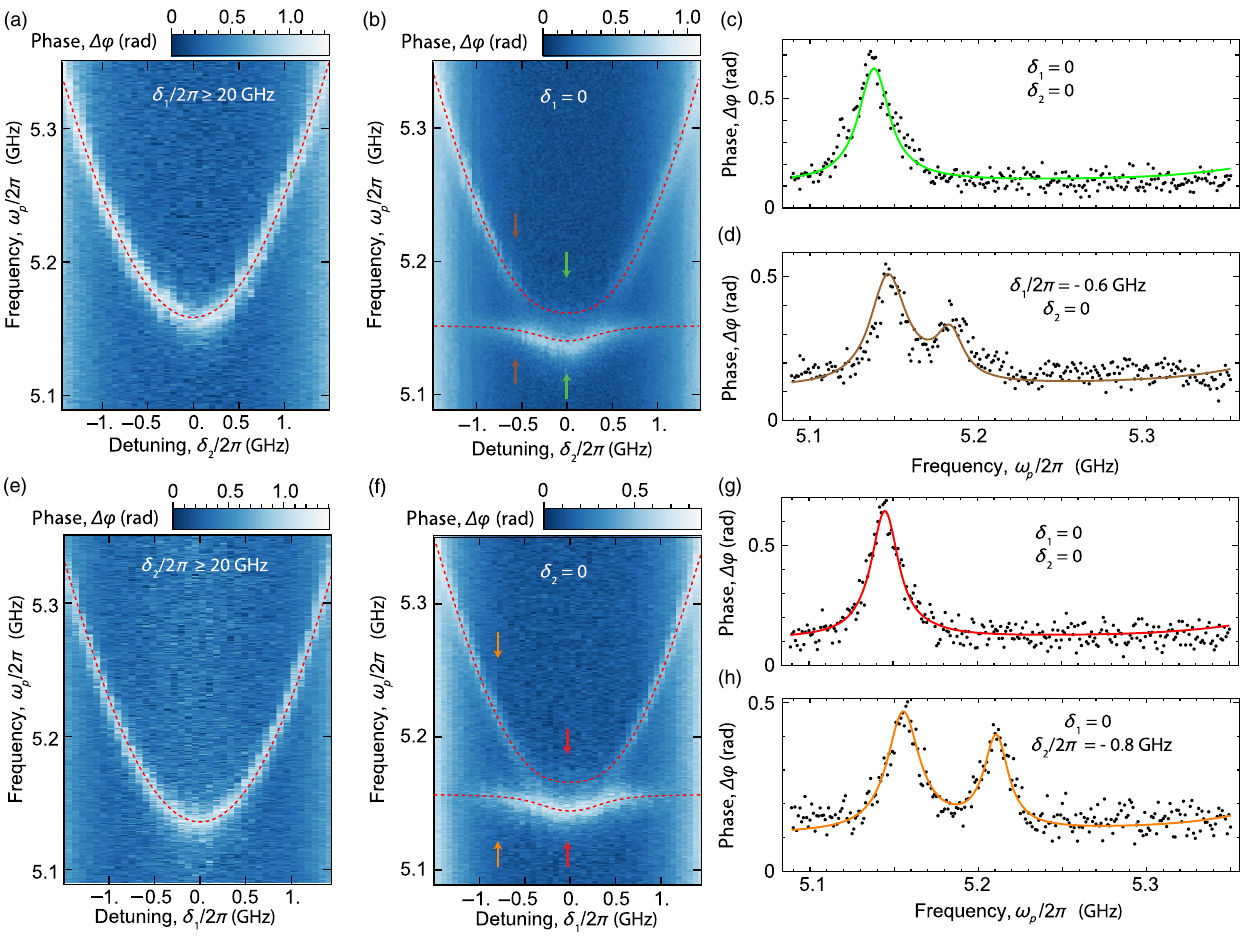
FIG. 10. Single- and two-qubit spectroscopy in the dispersive regime. The readout is performed at 5.454 GHz by populating the resonator with approximately 0.3 photons on average, for all data shown. Red dashed lines are fits to the master-equation simulations, and solid lines are master-equation simulations; see Appendix H. (a) Qubit spectroscopy of DQD 2 ( 2 t 2 = 2 π ¼ 5 . 168 GHz) vs detuning δ δ 2 π ≳ 20 GHz. (b) Qubit spectroscopy with DQD δ 0 and performing qubit spectroscopy vs δ 1 . DQD 1 is detuned to 1 = 1 at 1 ¼ 2 . 0 from (b) (red arrows), obtained at ω ω . (d) Line trace of (b) when both DQDs slightly detuned, (c) Line trace at δ 1 ; 2 ¼ DQD 1 ¼ DQD 2 ω ≠ ω , showing two separate resonances. (e) Qubit spectroscopy of DQD 1 ( 2 t 1 = 2 π ¼ 5 . 146 GHz) vs detuning δ 1 . DQD 2 is DQD 1 DQD 2 0 from (f) (red arrows) detuned to δ 2 = 2 π ≳ 20 GHz. (f) At δ 2 ¼ 0 qubit spectroscopy vs changing detuning δ 1 . (g) Line trace at δ 1 ; 2 ¼ showing one resonance peak. (h) Line trace of (f) for detuned